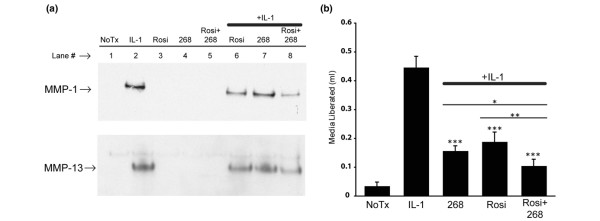
Protein levels and collagenolytic activity more strongly inhibited by dual treatment with LG268 and rosiglitazone. (a) SW-1353 cells were pretreated for 24 hours in serum-free media with 50 nM LG268, 50 nM rosiglitazone, or both, followed by treatment with interleukin-1-beta (IL-1β) for 24 hours. Protein was trichloracetic acid-precipitated from 1 mL of the conditioned media and resuspended in 40 μL of Laemmli buffer, and the entire sample was resolved using Tris-HEPES-SDS-PAGE and then transferred to a polyvinylidene difluoride membrane that was probed with anti-MMP-1 or anti-MMP-13 antibodies. (b) SW-1353 cells were embedded in a type I collagen matrix diluted to 1 mg/mL with serum-free media containing 50 nM LG268, 50 nM rosiglitazone, or both compounds. After gelation of the collagen, an additional 1 mL of serum-free media containing 50 nM LG268, 50 nM rosiglitazone, or both compounds was added on top of the gelled collagen and allowed to incubate for 24 hours. IL-1β was then added to the media to stimulate MMP production, and after 24 hours the media was recovered and quantified. Collagen breakdown is indicated by media quantities over 1 g, with the additional media being released from the collagen gel during destruction. Y values are the amount of media recovered over 1 mL. P values were calculated for the difference from the IL-1β-treated sample using the Student t test (*P < 0.05, **P < 0.005, ***P < 0.0005). 268, LG100268; MMP, matrix metalloproteinase; NoTx, no treatment; Rosi, rosiglitazone.